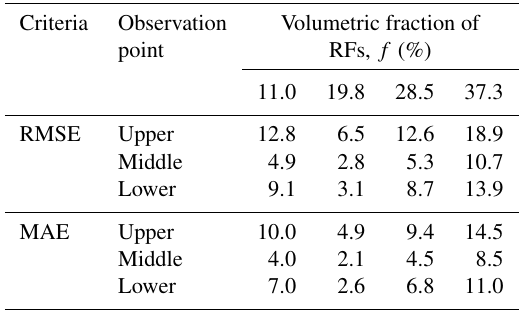
Table 1. The RMSE and MAE values between the observed and fitted pressure heads at three observation points for different values of f